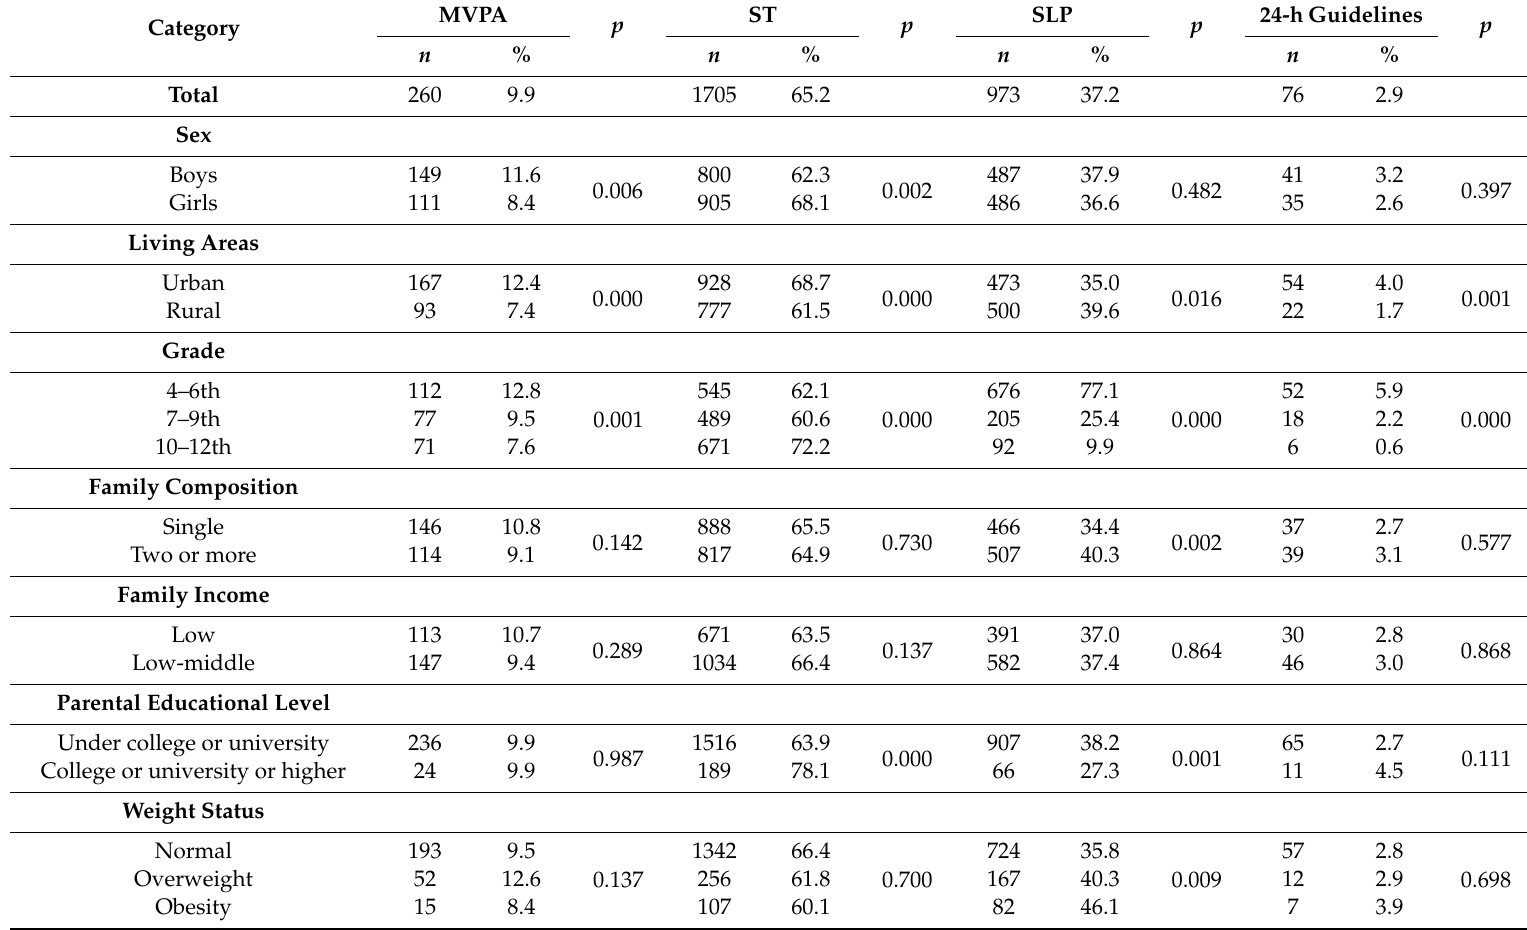
Table 2. Di ff erences in the prevalence of meeting the MVPA, ST, SLP, and 24-h